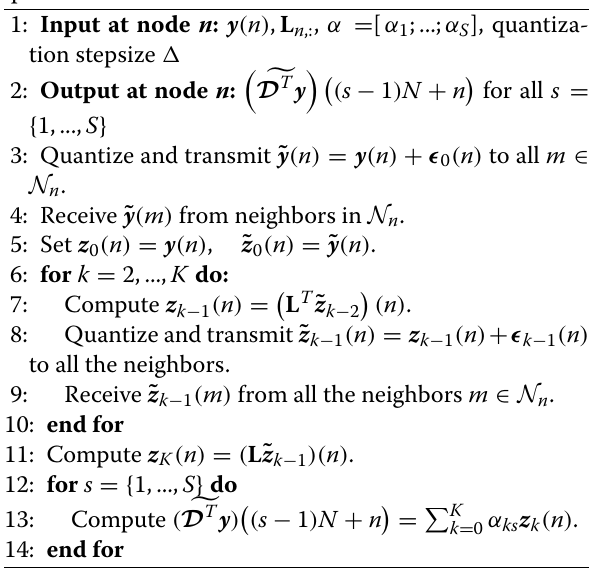
Algorithm 3 Distributed computation of D T y with quantization